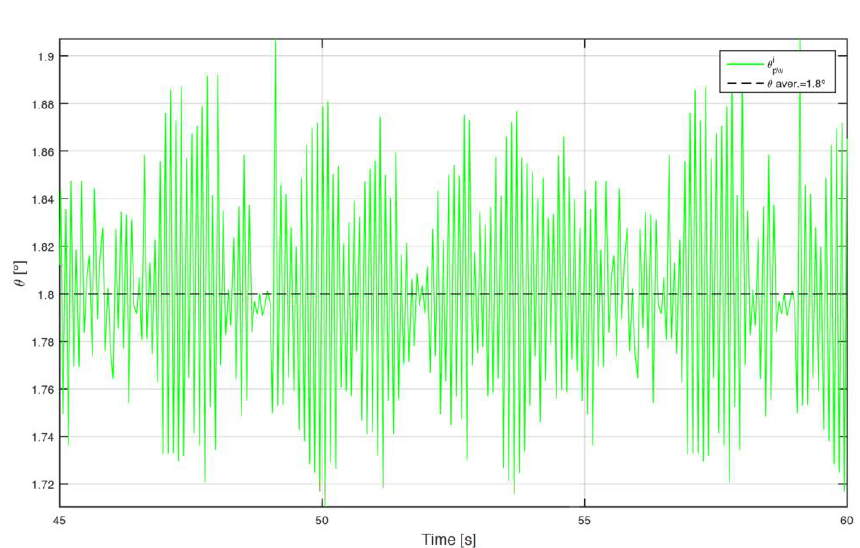
Figure 13. Bulk/void shift identification.